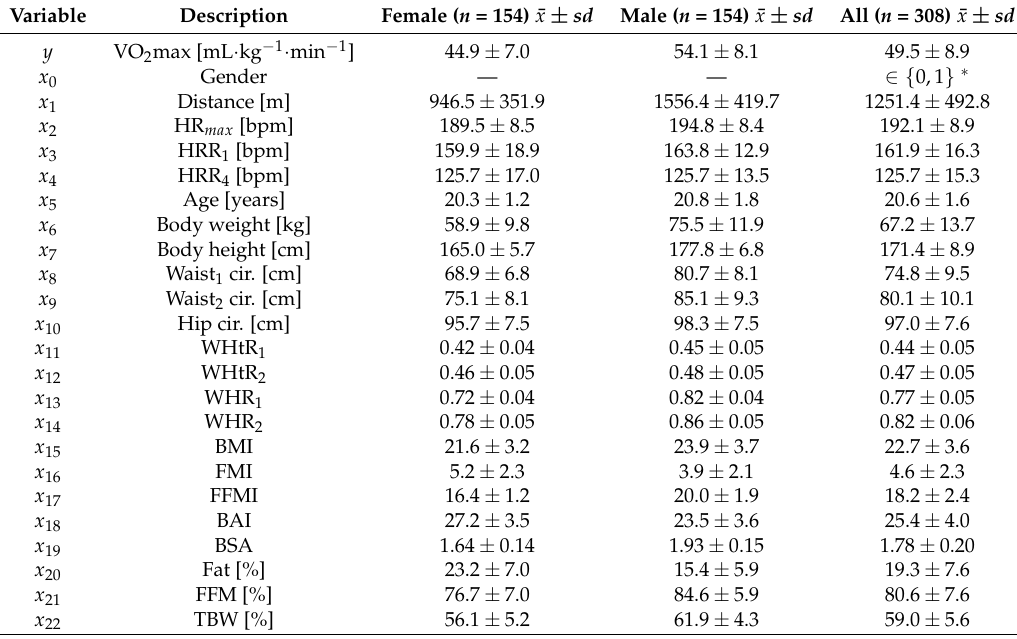
Table 2. Description of the variables used to construct the